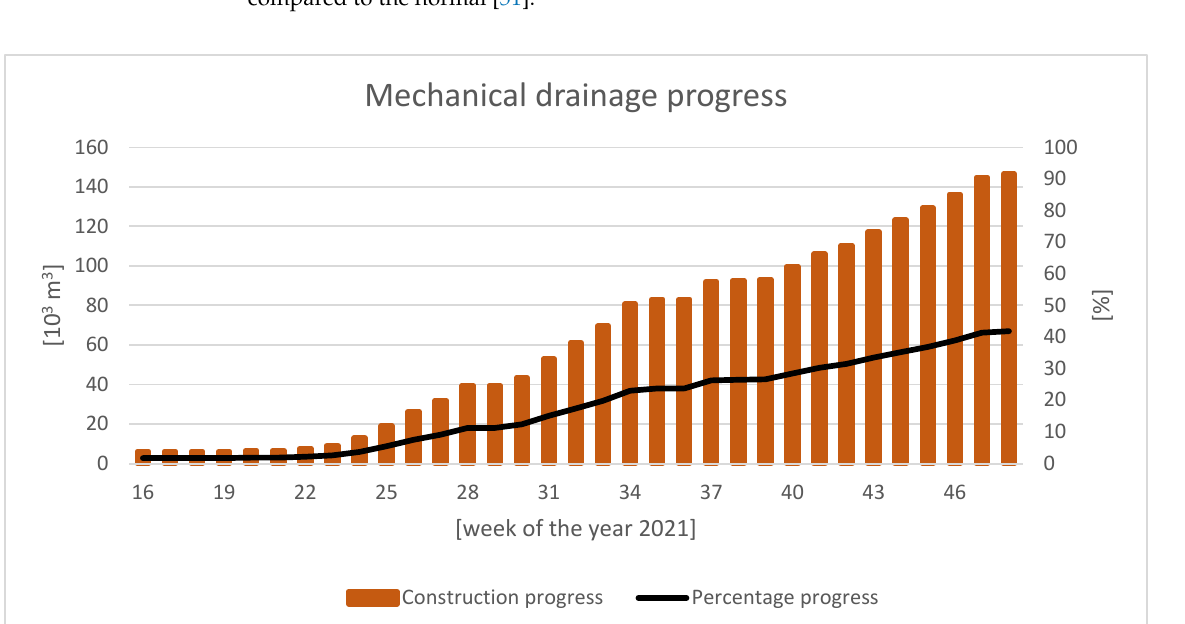
Figure 5. Average monthly temperatures and precipitation in the area of Szalejów Górny in 2021 as compared to the normal [51].